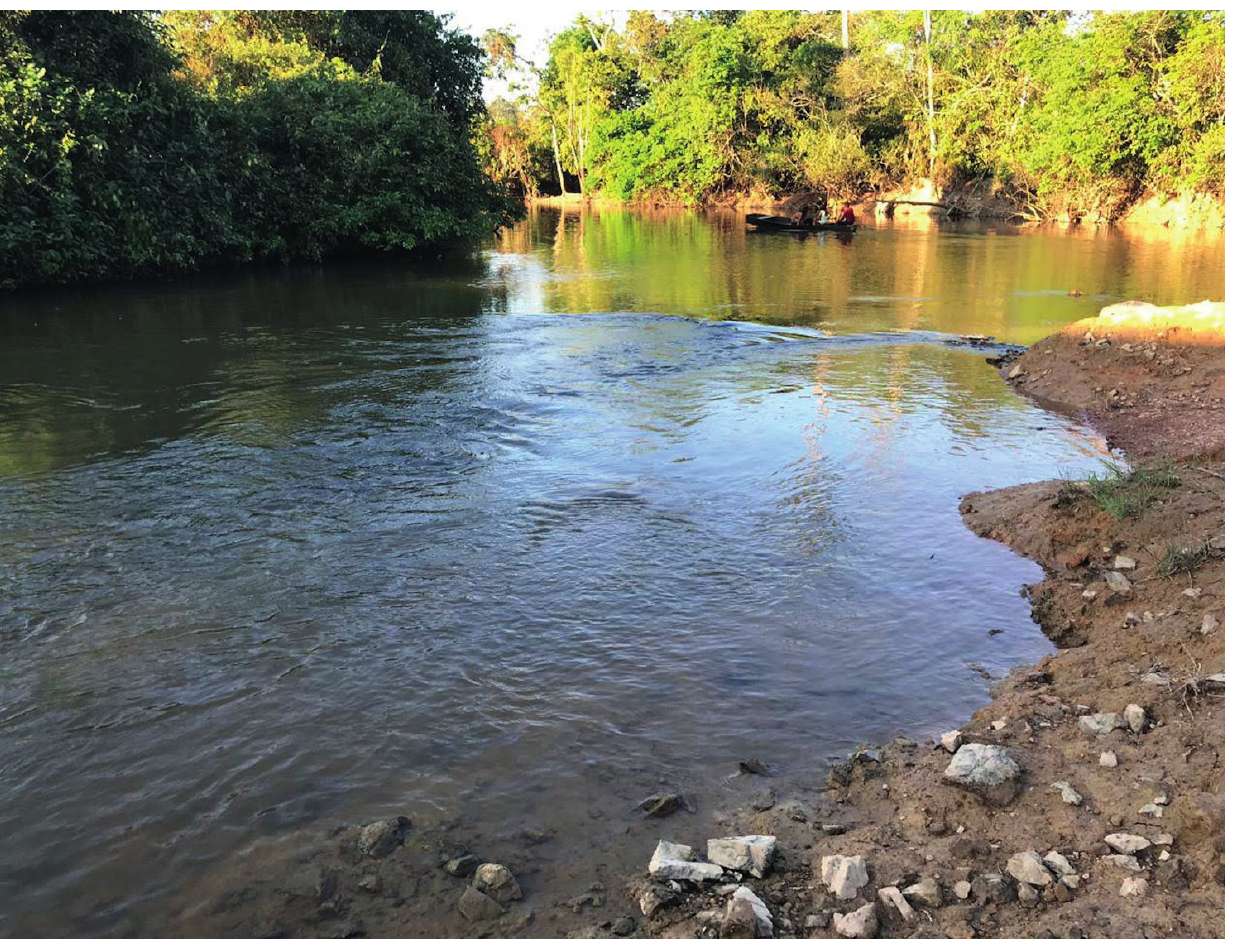
FIGURE 15 | Type locality of Corydoras psamathos , the igarapé Santa Júlia, a tributary to the rio Jamanxim, rio Tapajós basin in Pará State,